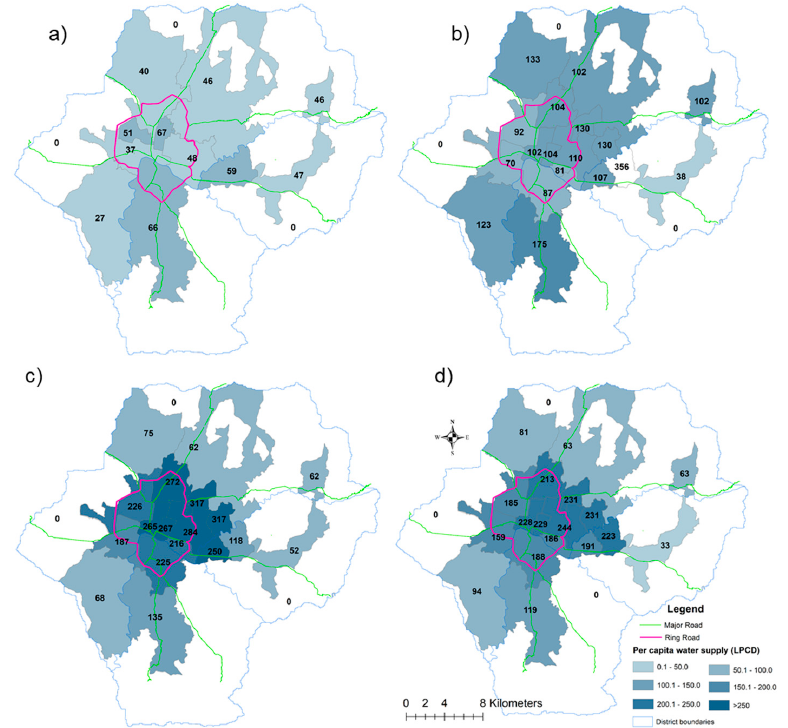
Figure 4. Per capita water supply (lpcd) in each service area: ( a ) current (2017), ( b ) after the first phase of MWSP), ( c ) after the second phase of MWSP, ( d ) post-MWSP (2030 or sustainable development target year).